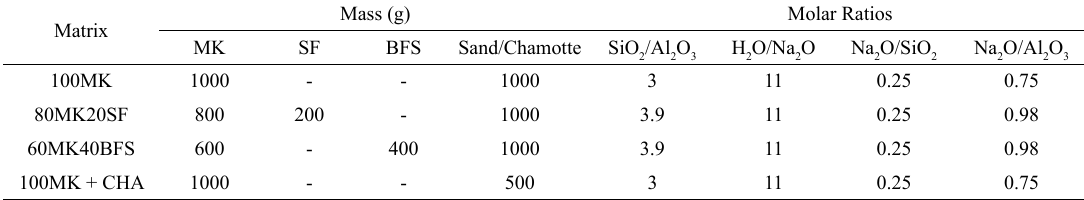
Table 3. Solid materials (mass) and molar ratios for each geopolymer matrix (with 1000g as reference). Matrix